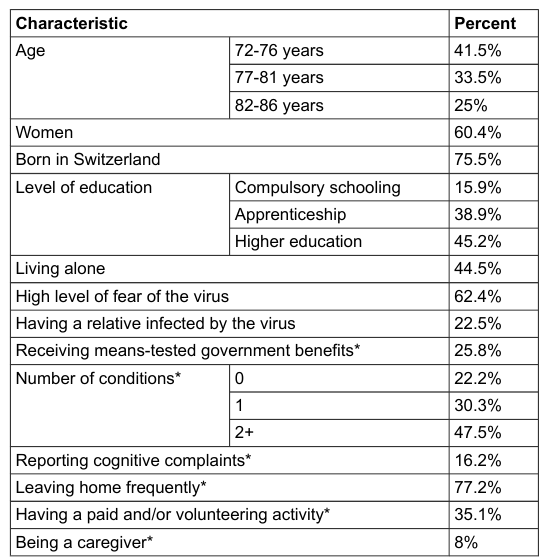
Table 2: Characteristics of the study sample.